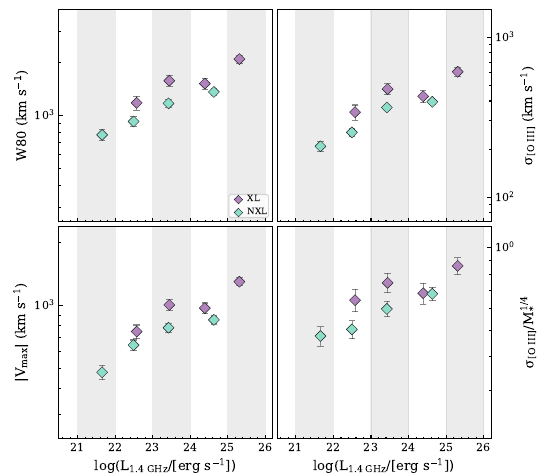
Figure 11. Same as Figure 10, but L 1.4GHz is in bins of 1 dex. Diamonds present the mean values in each bin for each sample. The error bars show Root-Mean-Square error (RMSE) in each